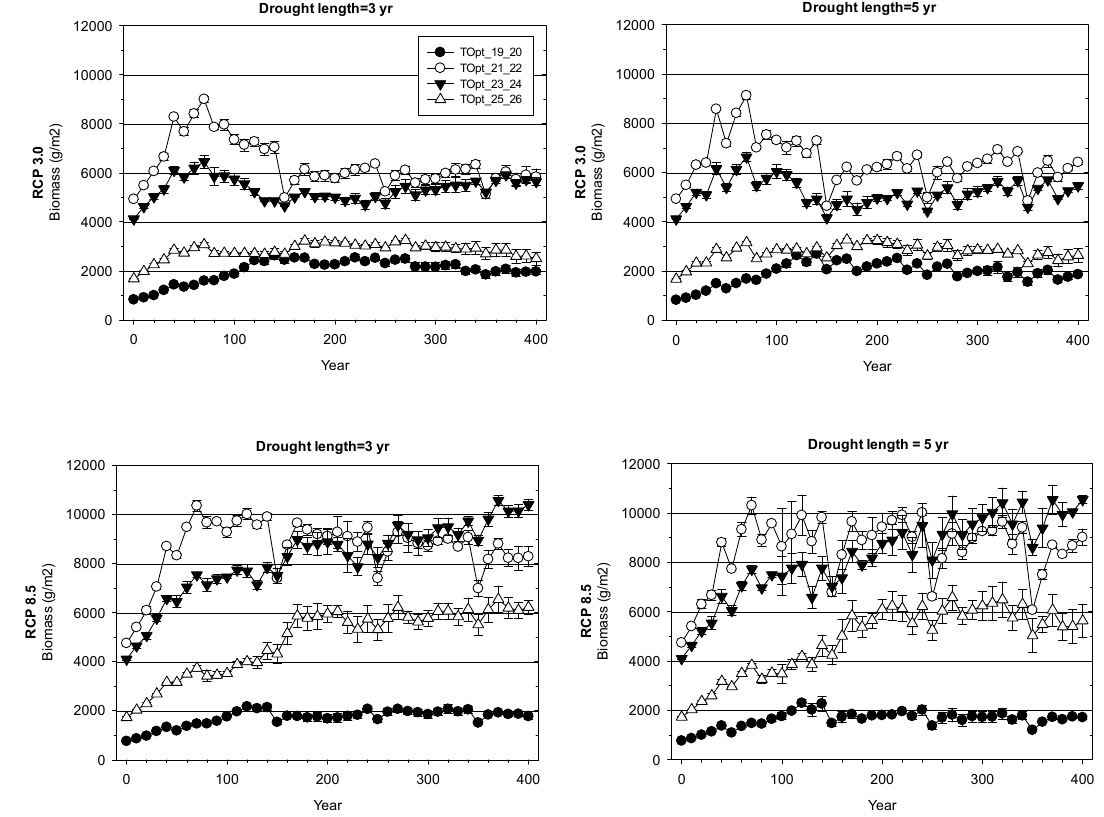
Figure 6. The effect of climate ( rows ) and drought length ( columns ) on productivity (mean species biomass) by optimal temperature groups. Error bars show one standard deviation.